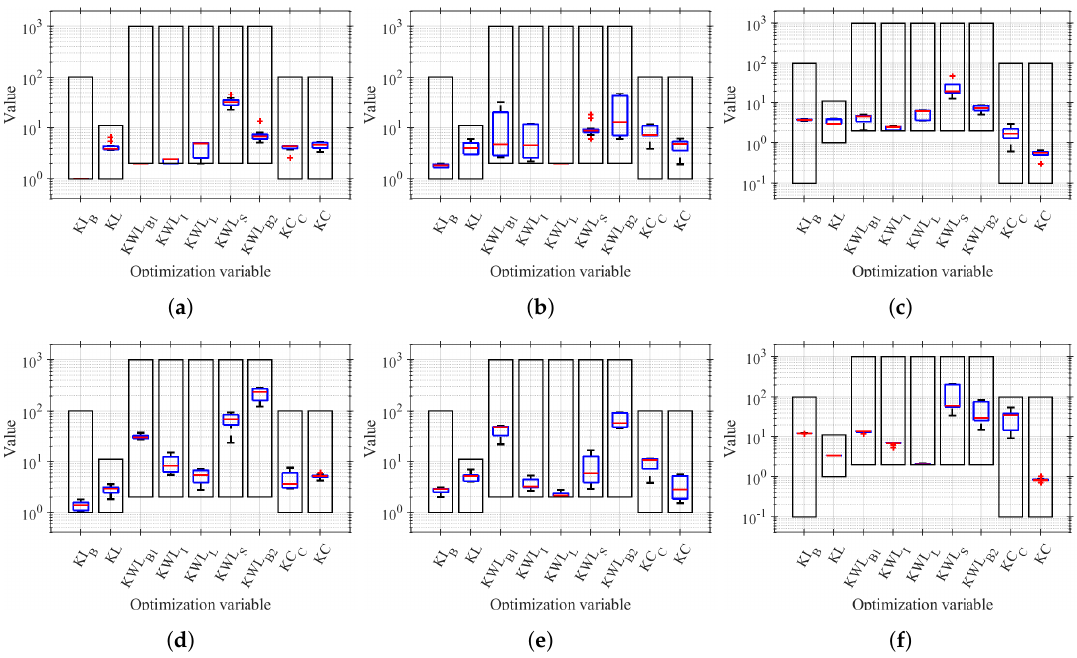
Figure 7. Values of the optimization variables from solutions in the Pareto front for the filter optimization ( FC = 100 KHz) obtained with: ( a ) SQP-180 nm, ( b ) SQP-130 nm, ( c ) SQP-65 nm, ( d ) NSGA-II-180 nm, ( e ) NSGA-II-130 nm, and ( f ) NSGA-II-65 nm.